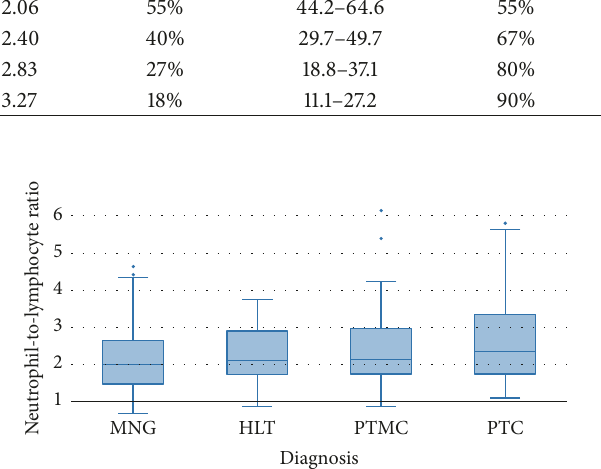
Figure 1: Comparison of neutrophil-to-lymphocyte ratio (mean ± SD) among the subgroups MNG, HLT, PTMC, and